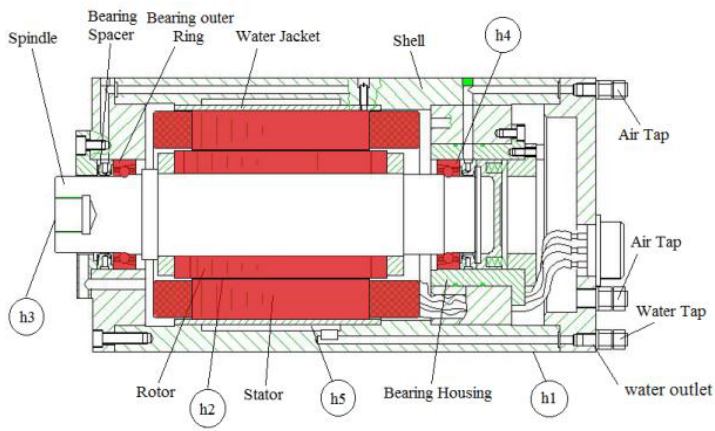
Figure 1. Structure of the motorized spindle.